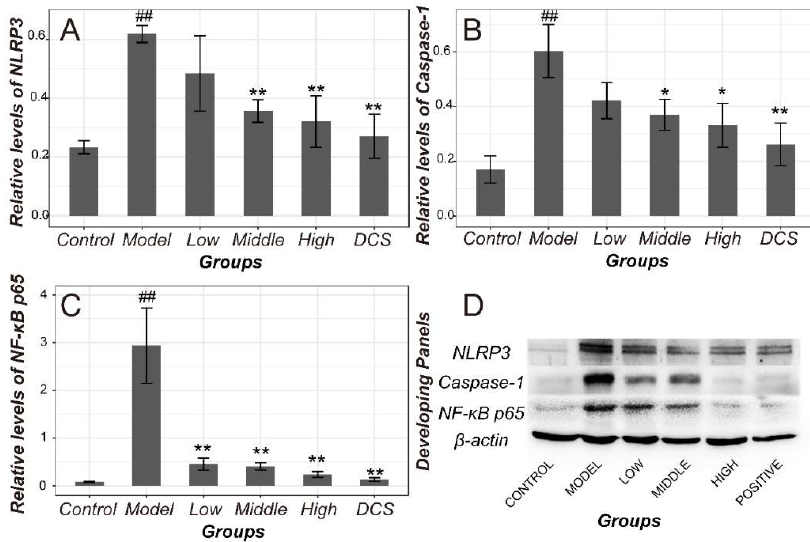
Figure 3. Protein levels of NF-κB and NLRP3/Caspase-1 pathway in CIA rats. Results of optical density of NLRP3 ( A ), caspase-1 ( B ), NF-κB p65 ( C ) estimated by integrated optical density (IOD index) and normalized against β-actin in all groups. ( D )The representative Chemiluminescencez panels of all protein membranes. DCS, Diclofenac sodium. ## p < 0.01 vs. Control. * p < 0.05 vs. Model. ** p < 0.01 vs.